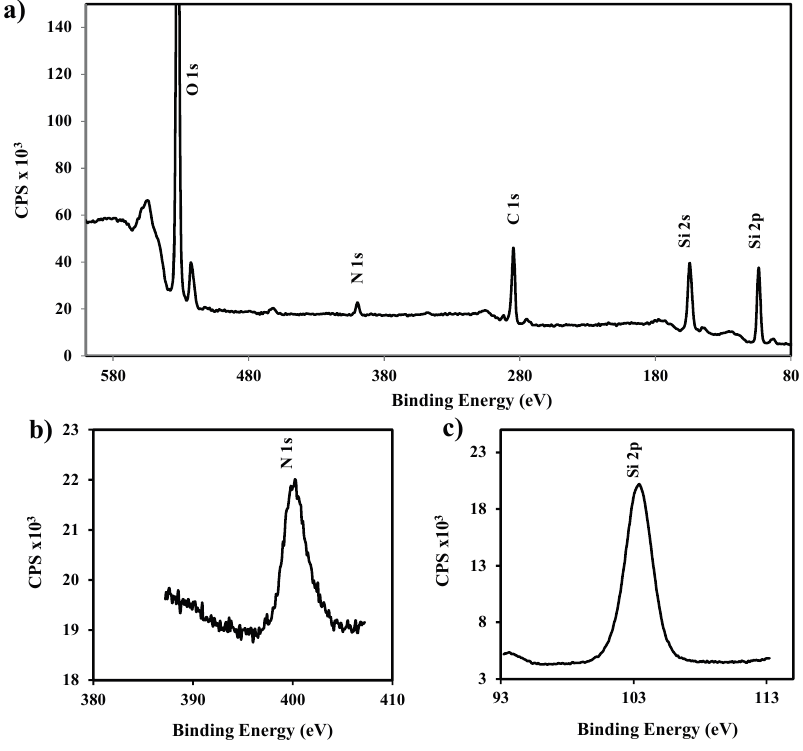
Figure 4. Full scale XPS spectra ( a ) and details corresponding to silicon ( b ) and nitrogen ( c ) XPS signals detected in the functionalized silica